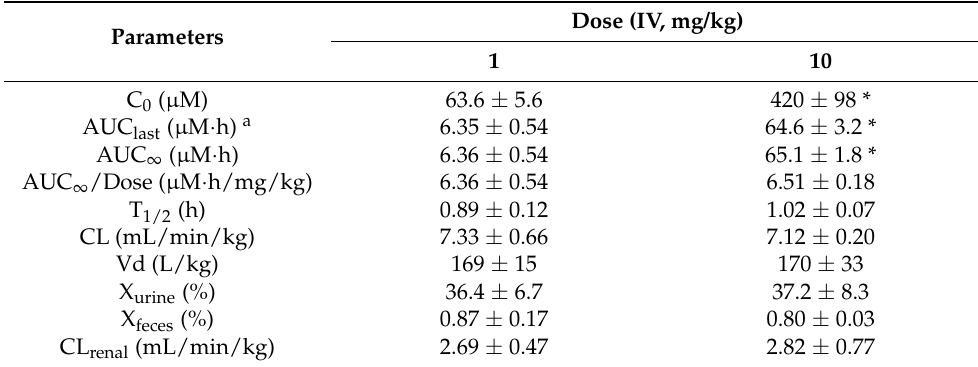
Figure 2. The plasma concentration-time profile of rosmarinic acid following the intravenous injection of rosmarinic acid at doses of 1 mg/kg and 10 mg/kg. Each data point represents the mean ± standard deviation ( n = 4). Table 1. Pharmacokinetic parameters of rosmarinic acid in rats.